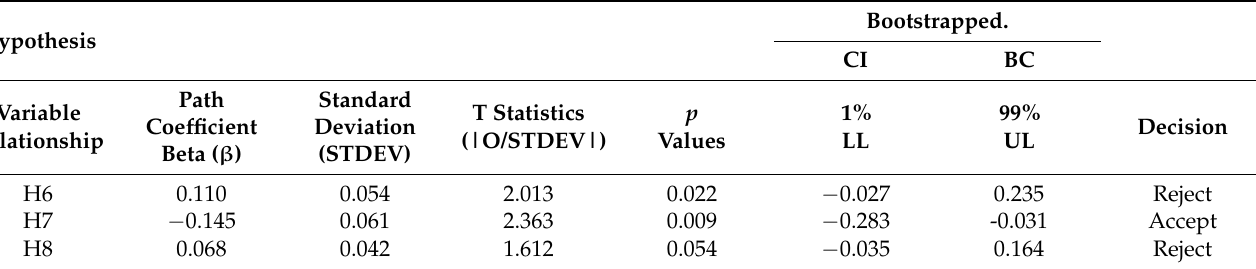
Table 7. Summary of Moderation Test